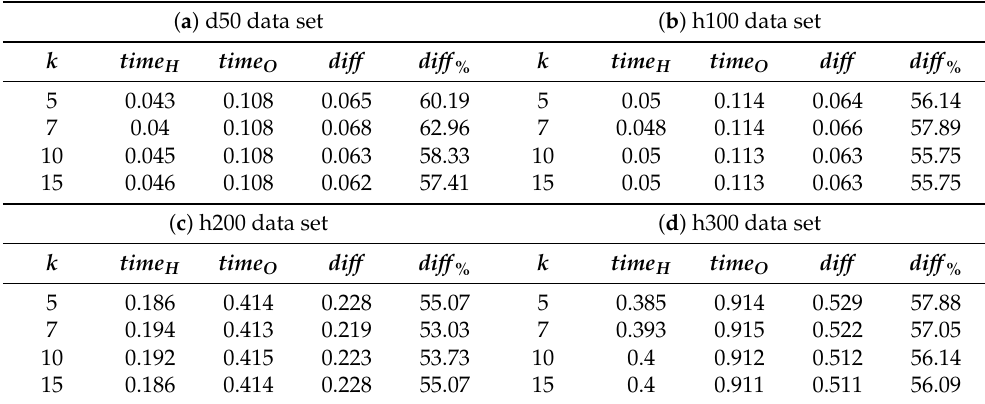
Table 3. Average run time in seconds on different data sets depending on the length of the k-mers in the case of affine gap